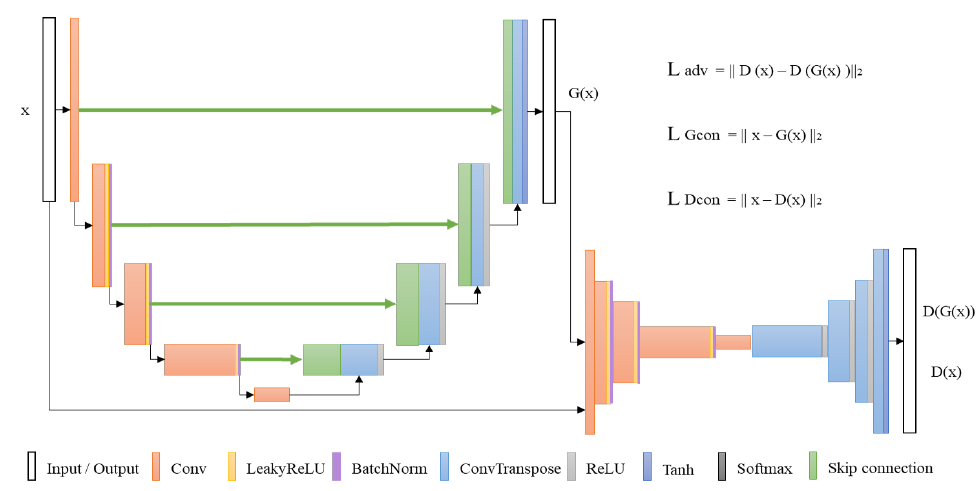
Figure 2. Pipeline of the proposed method